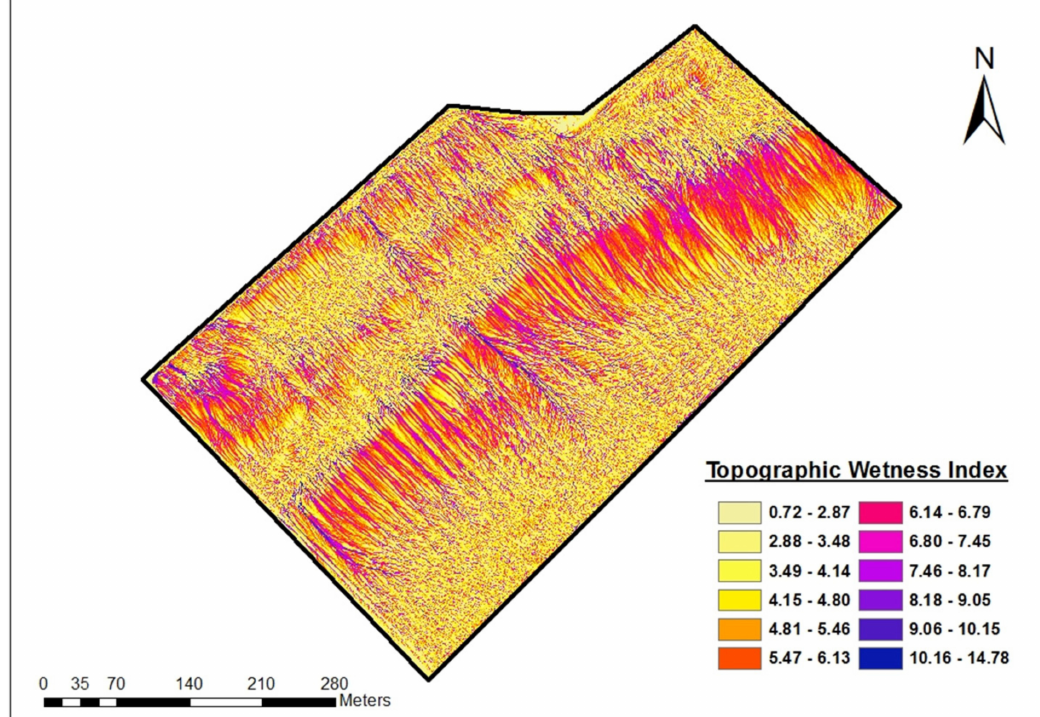
Figure 2. Topographic wetness index map of study